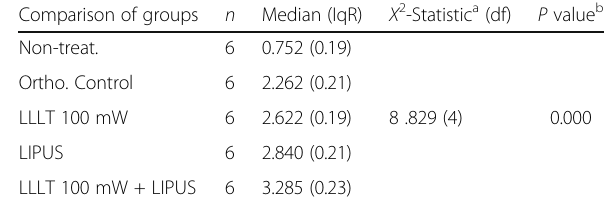
Table 6 Comparison of median of RUNX2 gene expression levels among the study groups at day 21 Comparison of